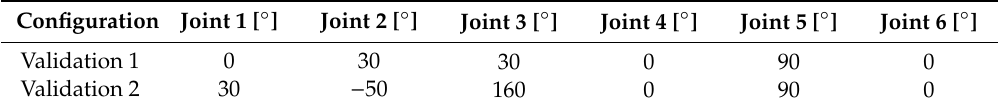
Table 3. Robot validation configurations.